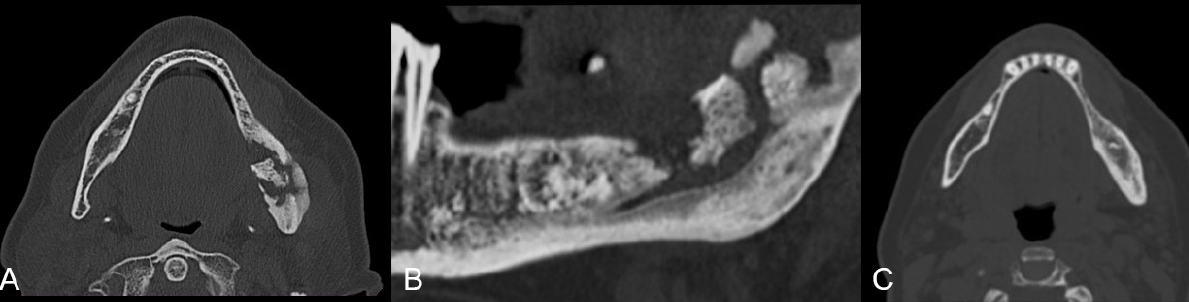
Figure 4. Group B patient. Radiological pre-operative assessment through cone beam computed tomography of a stage 2 maxillary and mandibular MRONJ. Axial view ( A ) and mandibular view ( B ). Twelve months follow-up axial view ( C ).